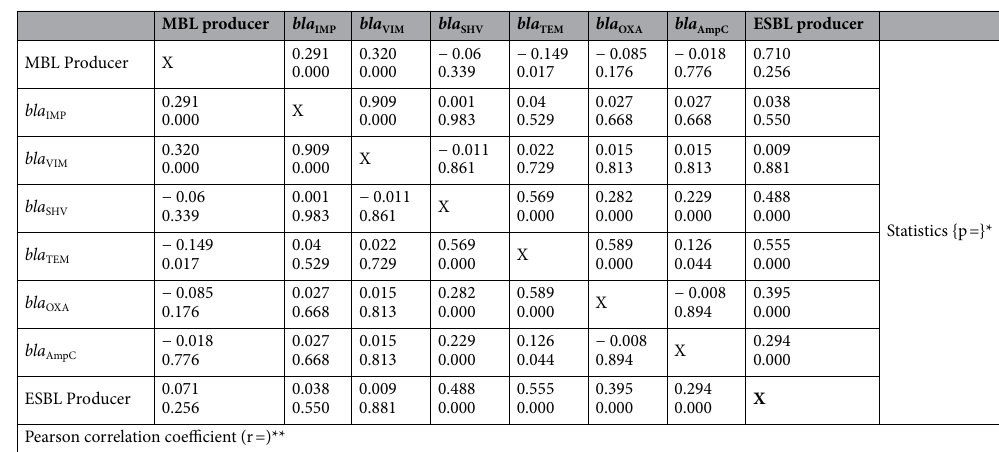
Table 5. Correlation matrix of phenotypic and genotypic MDR isolates of Pseudomonas aeruginosa by Pearson correlation co-efficient. *p value ≤ 0.05 was considered statistically significant. **Based on Pearson-correlation coefficient (r), the association between the phenotypic and genotypic variables was determined as: |r|< 0.3; weak correlation, 0.3 <|r|< 0.5; moderate correlation, 0.5 <|r|< 0.85; strong